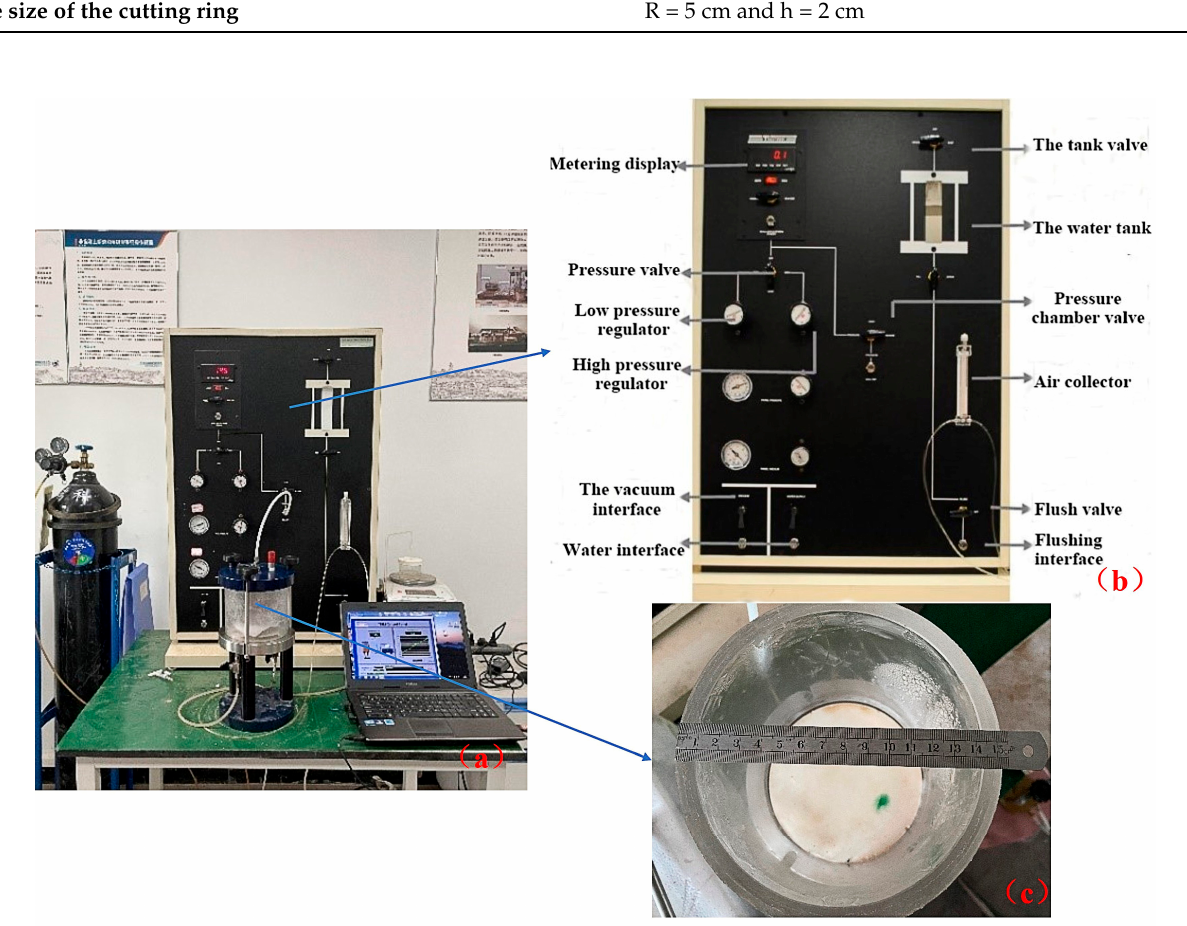
Figure 7. TRIM System ( a ) Equipment, ( b )control panels, and ( c ) pressure chambers.